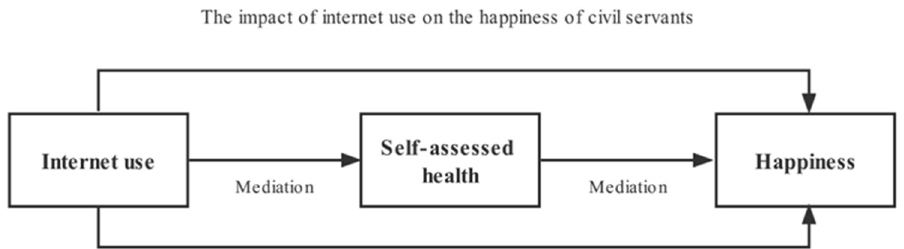
Figure 1. Theoretical framework diagram.